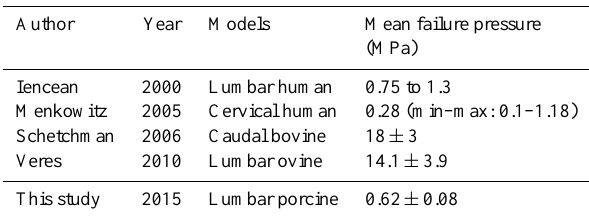
Table 2. Recent data about failure pressure data for different IVD